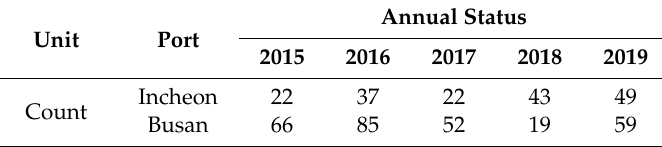
Table 5. Summary of marine accidents in the Incheon and Busan ports of Korea from